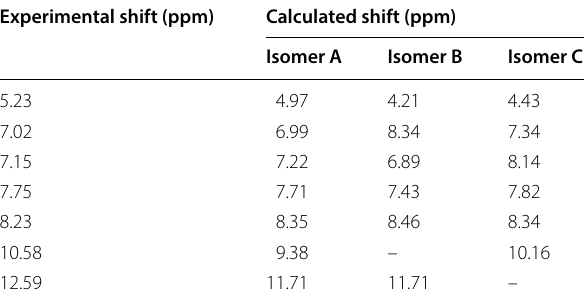
Table 2 Comparing of experimental shift (ppm) and calcu- lated shift (ppm) possible isomers